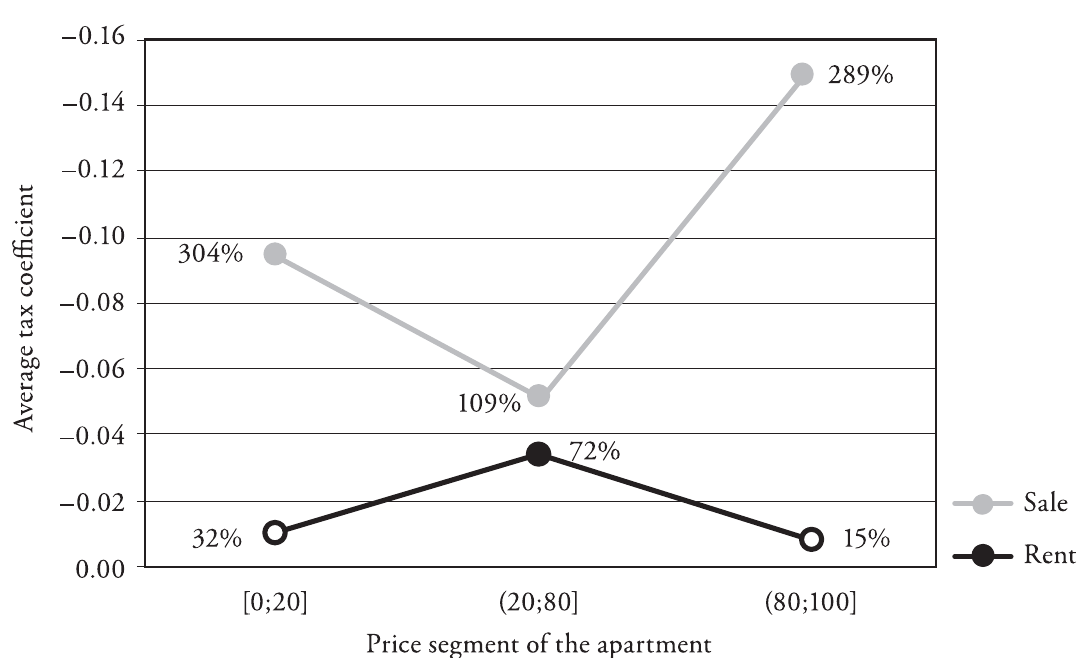
Figure 2: Degree of